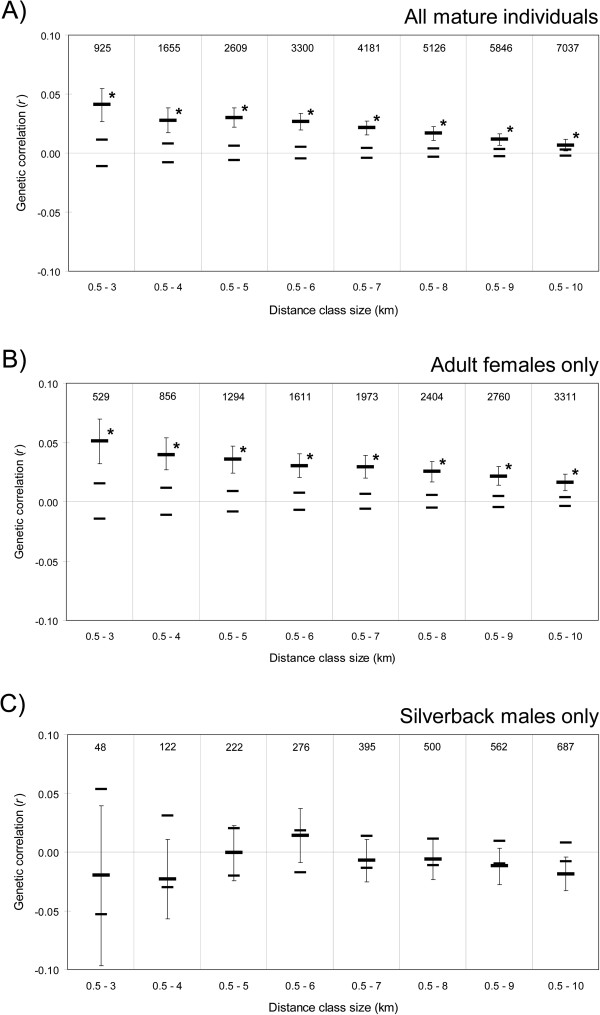
Influence of modifying the second distance class on the spatial autocorrelation analyses. Only the second distance class is shown, for increasing distance class sizes from 3 to 10 km. The thicker line denotes the genetic correlation coefficient (r), and the thinner lines indicate lower and upper bounds of the 95% confidence interval about the null hypothesis of a random distribution of genotypes. Bootstrapped 95% confidence error bars are also shown. The number of pairwise comparisons within each distance class size is presented above the plotted values. (A) All mature individuals (n = 158); (B) Adult females only (n = 109); (C) Silverback males only (n = 49). Asterisks denote r values significant at α = 0.05.